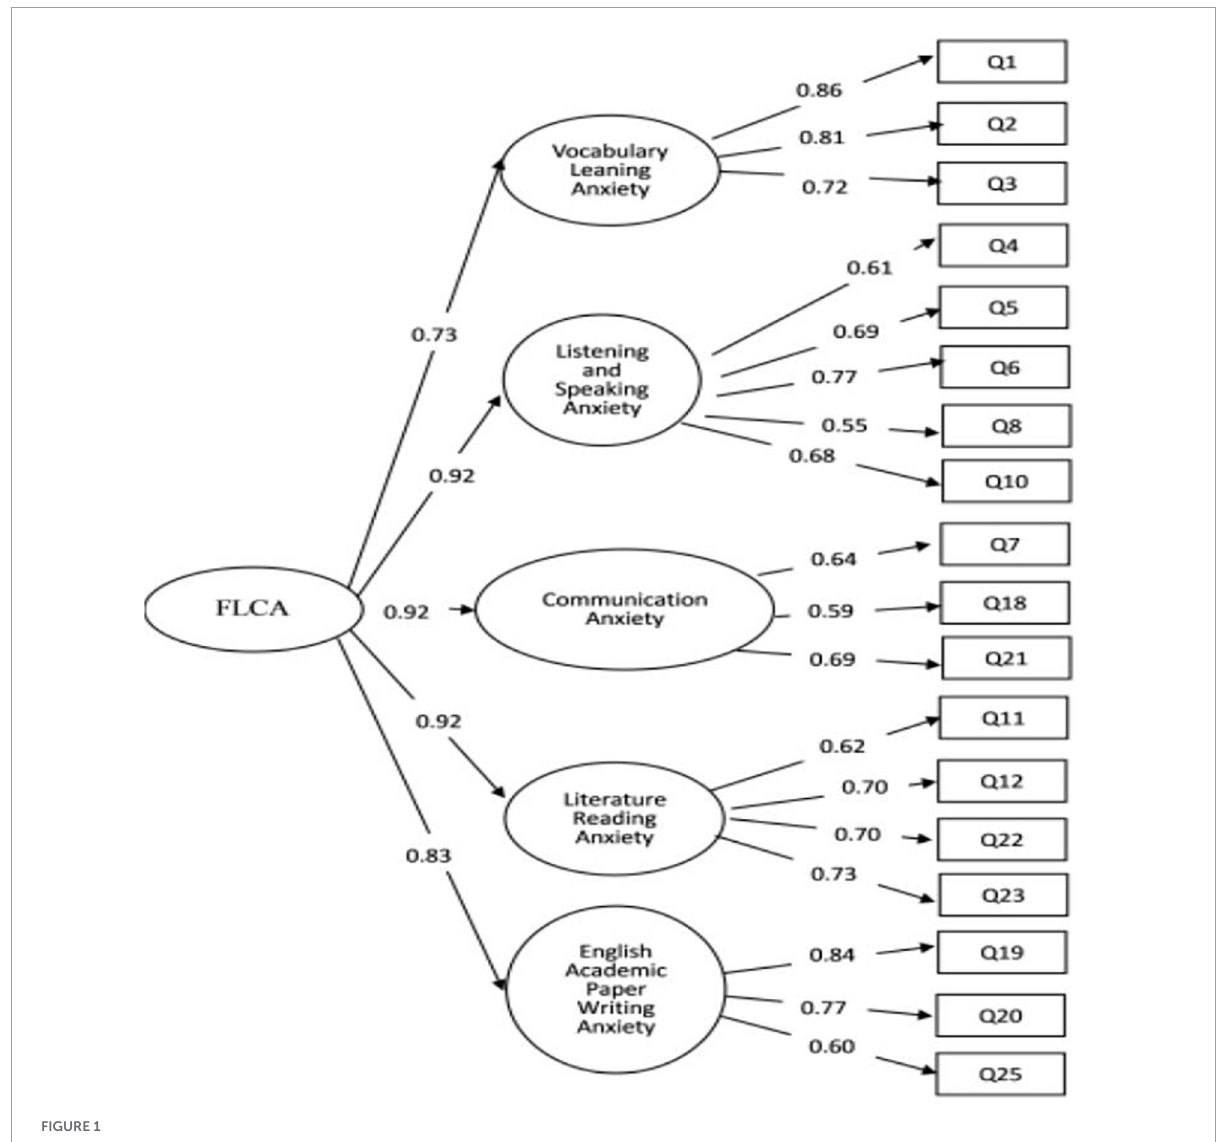
FIGURE1 Second-order confirmatory factor analysis (structural equation model).